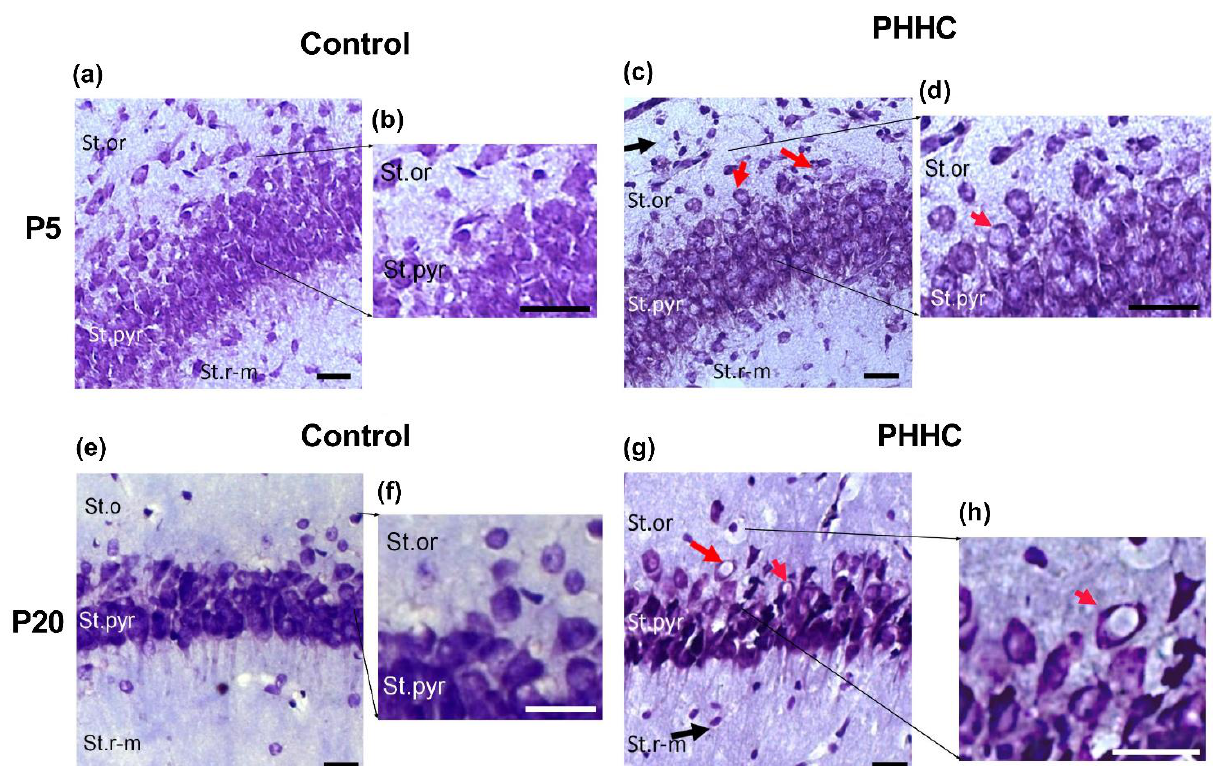
Figure 1. Microphotographs of the CA1 hippocampus tissue of the pups on P5 ( a – d ) and P20 ( e – h ) from control ( a , b , e , f ) and PHHC ( c , d , g , h ) groups. Scale ( a , c , e , g ): 30 µ m; ( b , d , f , h ): 40 µ m. Nissl staining. Red arrows: degenerating neurons; black arrows: glia cells. The layers of the CA1 area of the dorsal hippocampus are shown on the left part of microphotographs: St.pyr, stratum pyramidale; St.o, stratum oriens; St.r-m, stratum radiatum-moleculare; PHHC, prenatal hyperho- mocysteinemia.